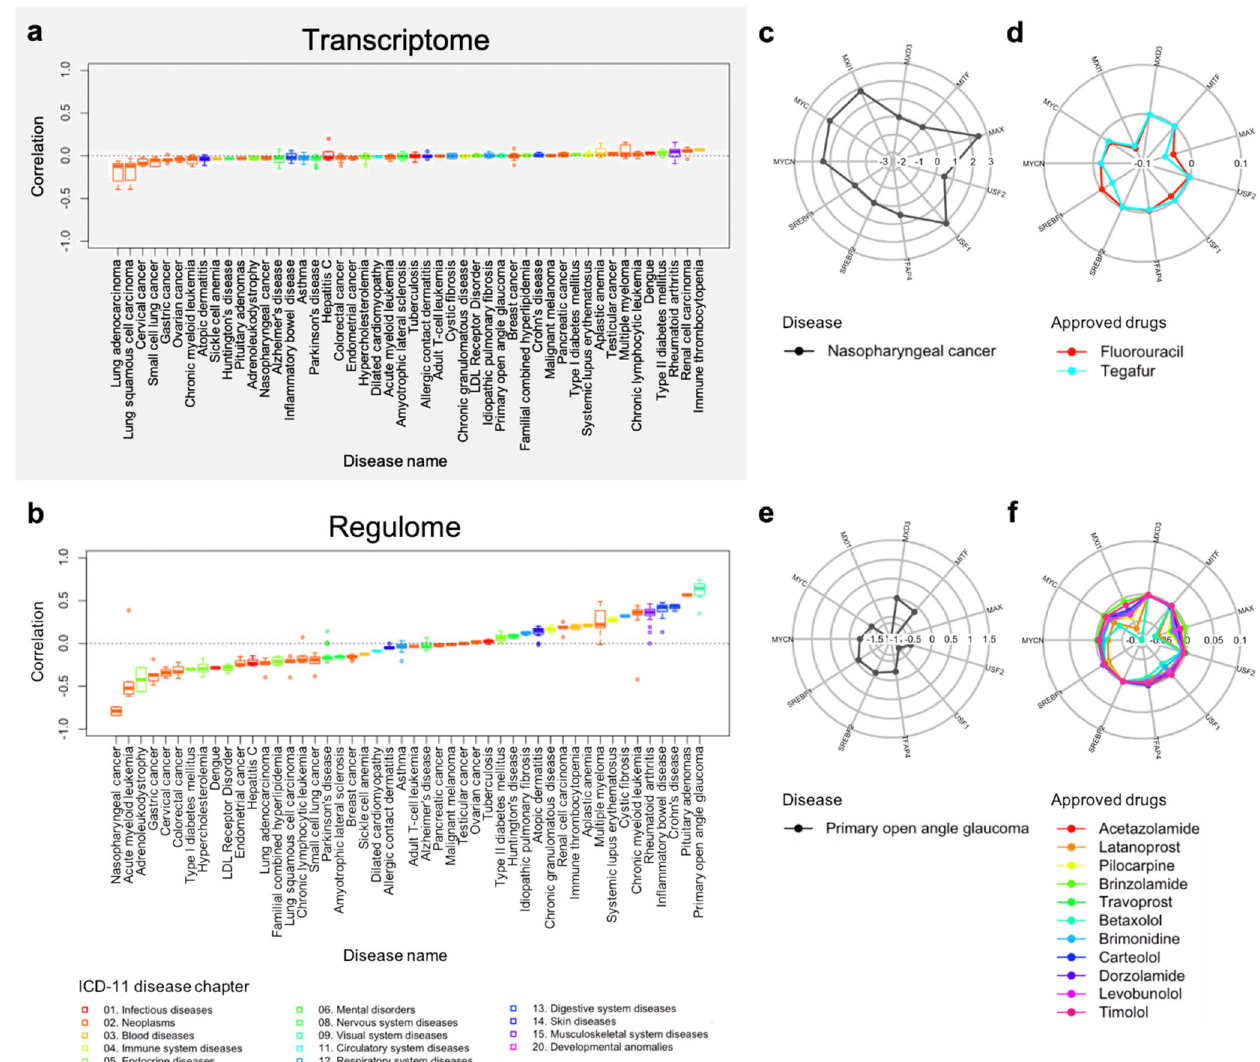
Fig. 3 Relationships between diseases and their approved drugs. a Distribution of correlation scores between transcriptome-based drug and disease signatures. b Distribution of correlation scores between regulome-based drug and disease signatures. Each boxplot represents correlation scores of the drugs approved for the corresponding disease. The horizontal axis indicates the list of diseases and the vertical axis indicates cosine correlation coef fi cient. Diseases are listed in order of increasing median correlation scores. In the box plots: center line, median; box, interquartile range; whiskers, 1.5× interquartile range; dots, outliers. c Radial plot of enrichment scores for transcription factors in the regulome signature of nasopharyngeal cancer. d Radial plot of enrichment scores for transcription factors in the regulome signature of approved drugs for nasopharyngeal cancer. e Radial plot of enrichment scores for transcription factors in the regulome signature of primary open angle glaucoma. f Radial plot of enrichment scores for transcription factors in the regulome signature of approved drugs for primary open angle